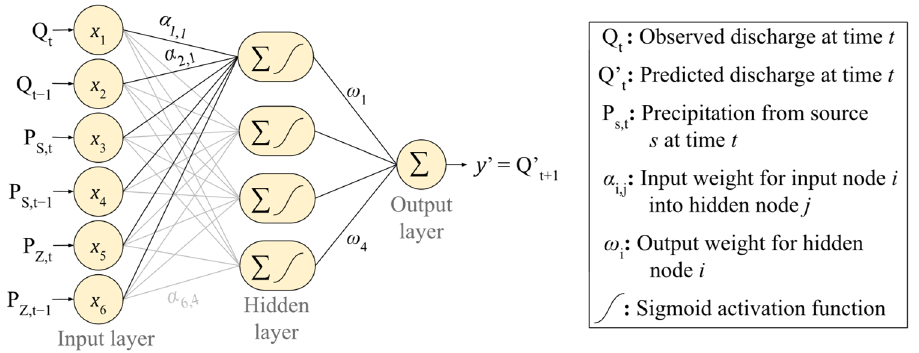
Figure 3. Visual representation of a hypothetical ELM structure as adopted in this work. It takes two QPE products (S and Z) and antecedent discharge as input to predict the instant discharge one unit of time (hour) in the future.